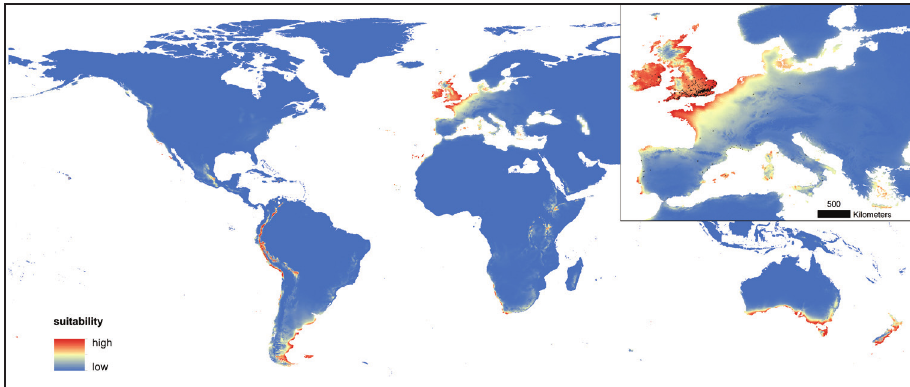
Figure 3. Global climatic suitability of Steatoda nobilis . Mean Maxent prediction, black dots in insert depict known invasive populations in Europe (insert is not masking suitable